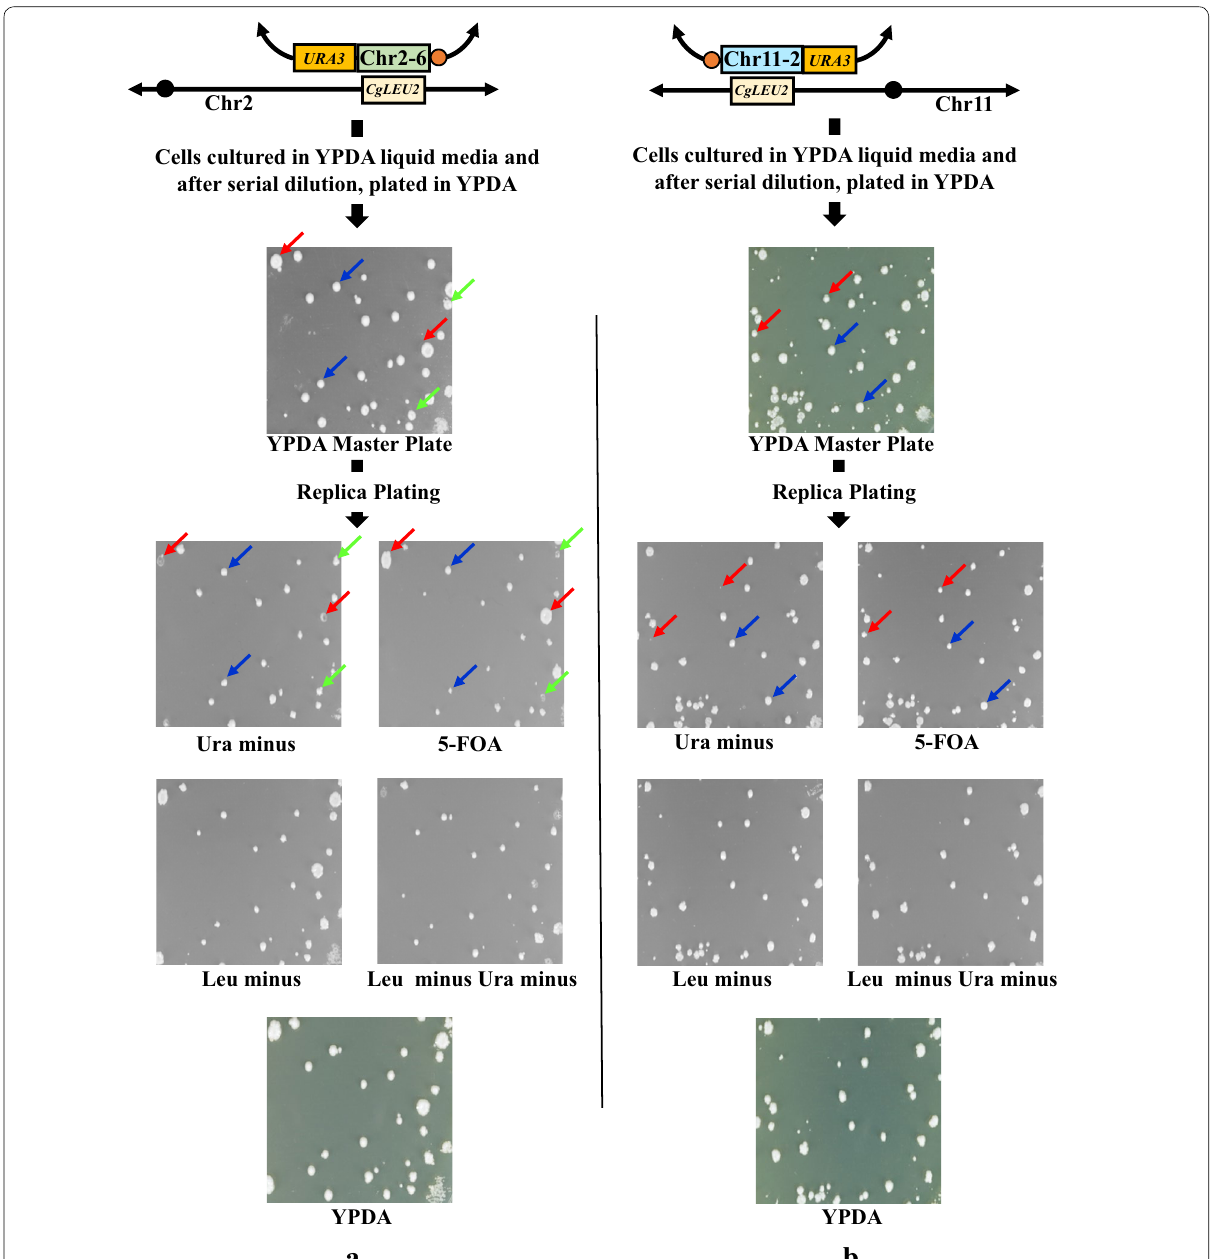
Fig. 8 Mini-chromosome loss assay of duplicated mini-chromosome. a Represents transformants harboring Chr2-6 (dup rep) and b represents + transformant containing Chr11-2 (dup rep), respectively. After serial dilution of full growth culture in YPDA liquid medium, cells were plated on + YPDA plate. This YPDA plate was treated as a master plate for subsequent replica-plating experiment. After colonies appeared on YPDA plate, the YPDA plate was replica-plated on Leu minus, Ura minus, Leu and Ura minus media, 5-FOA and YPDA plates as a control. After incubation, we found that cells plated on YPDA master plate formed three types of colonies for Chr2-6 (dup rep) and two types of colonies for Chr11-2 (dup rep) + + cases. In both cases, one type of colonies were supposed to lose mini-chromosome. As a consequence, they showed Ura − and 5-FOA + phenotype. Two representatives of this type of colonies were marked with red-colored arrow. On the other hand, most of other colonies of both cases were supposed to keep mini-chromosome for which they showed Ura + phenotype but they also formed colonies in 5-FOA medium. We think that these colonies consist of cells lost mini-chromosome and therefore they showed 5-FOA + phenotype. Two of this type of colonies were marked with blue-colored arrow. Besides, in only Chr2-6 (dup rep) case, we found very few colonies which were supposed to hold mini-chromosome and + therefore showed Ura + phenotype but which, by unknown reason, did not lose mini-chromosome and consequently showed 5-FOA − phenotype. Two representatives of this type of colonies were marked with green-colored